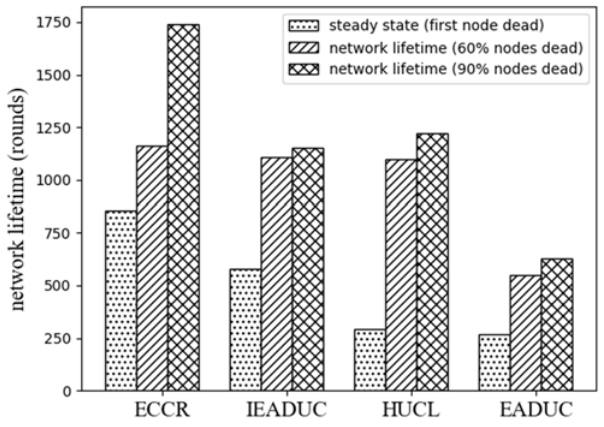
Figure 10. Network Figure 10. Network lifetime.